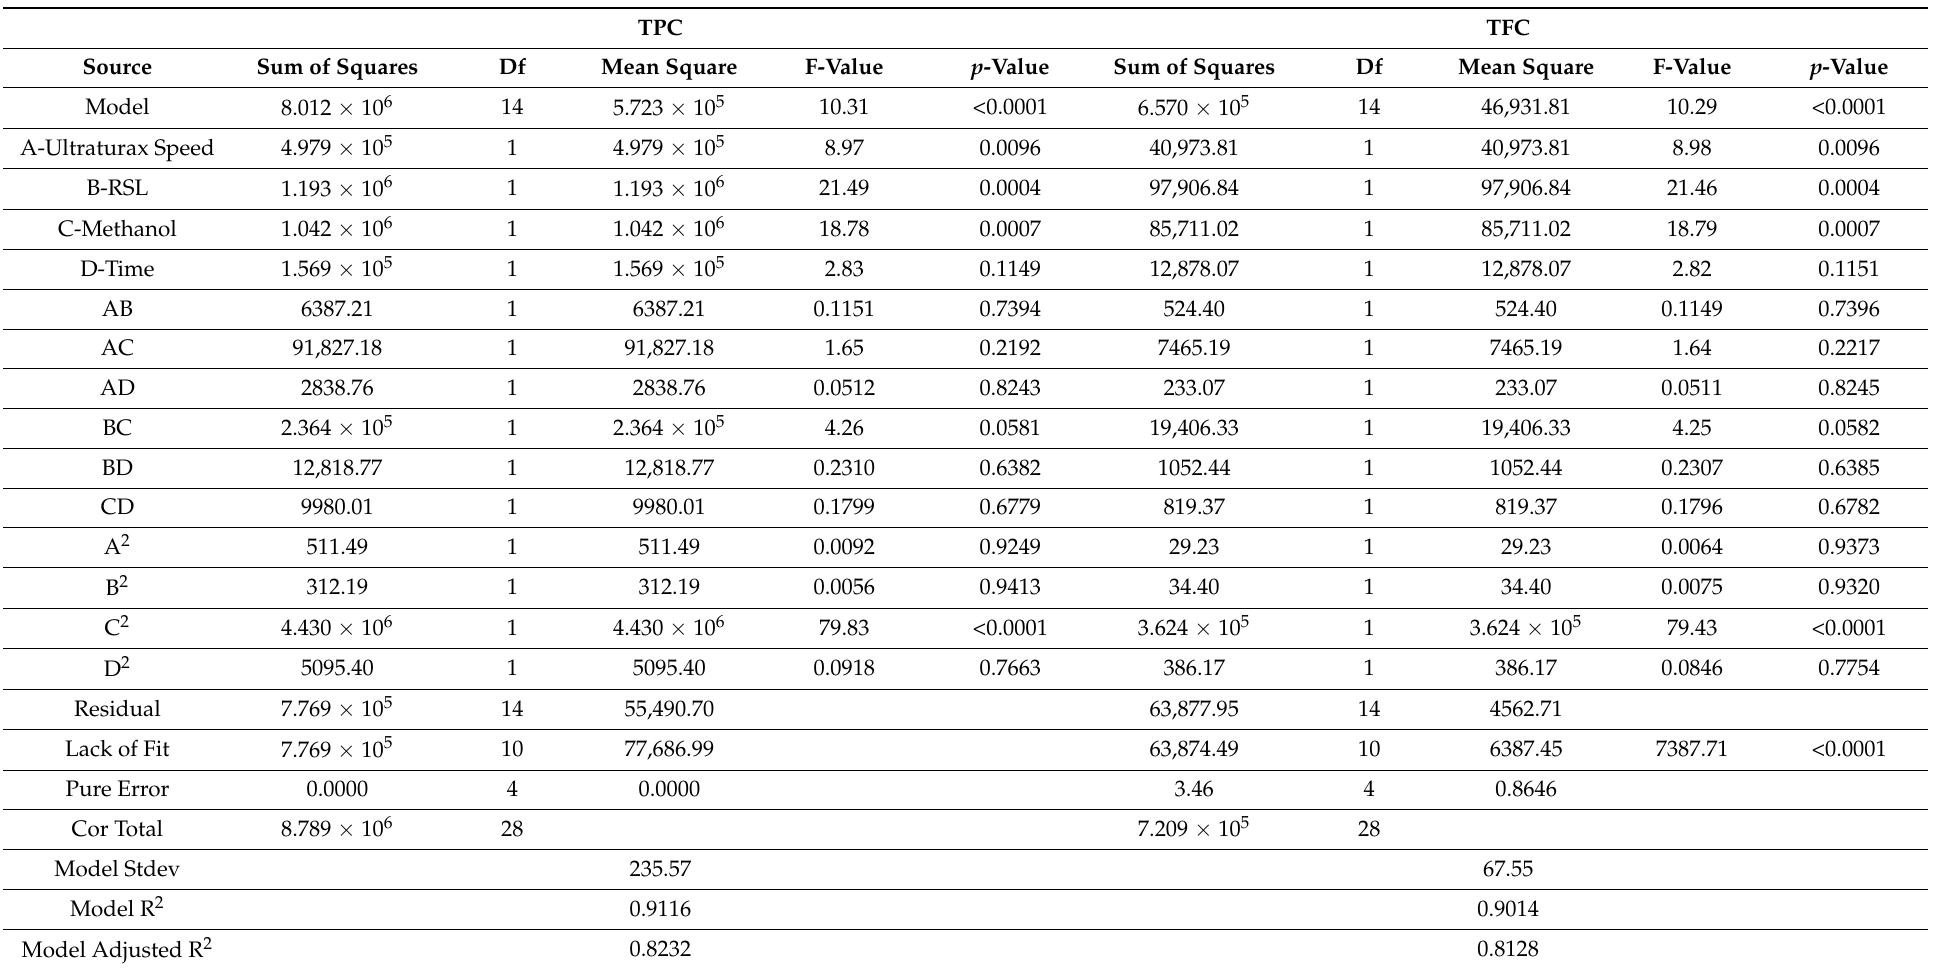
Table 2. Analysis of variance of the total phenolic content (TPC) and total flavonoid content (TFC) modeling using the Box–Benhken